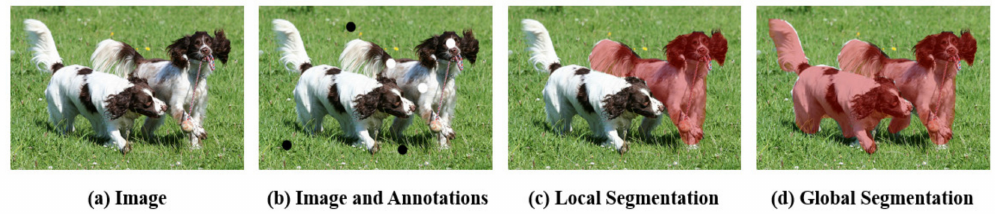
Figure 4. Globalizing the task representation propagation: In this example, we annotate a single dog ( b ) on the image ( a ), but global guidance causes all similar dogs to be segmented ( d ) instead of segmenting an annotated dog ( c